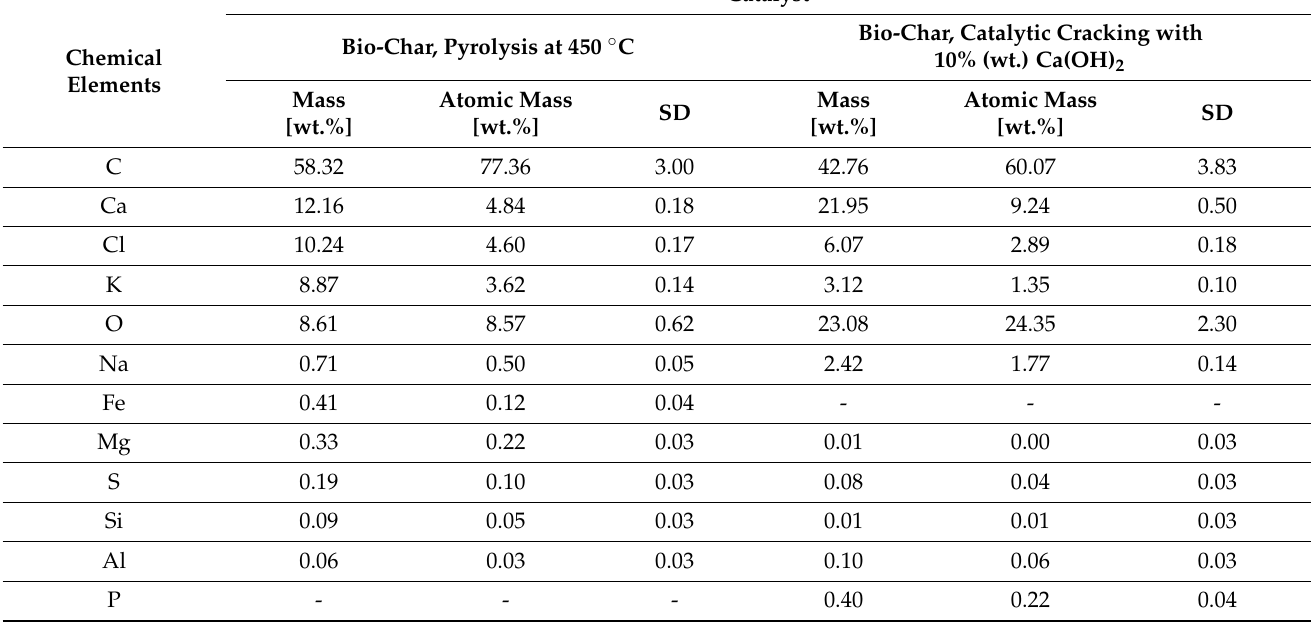
Table 4. Percentages in mass and atomic mass of bio-chars obtained by pyrolysis of (organic matter + paper) fraction of MHSW at 450 ◦ C, 1.0 atmosphere, and by catalytic cracking of (organic matter + paper) fraction of MHSW at 475 ◦ C, 1.0 atmosphere, with 10.0% (wt.) Ca(OH) 2 as catalyst, in laboratory